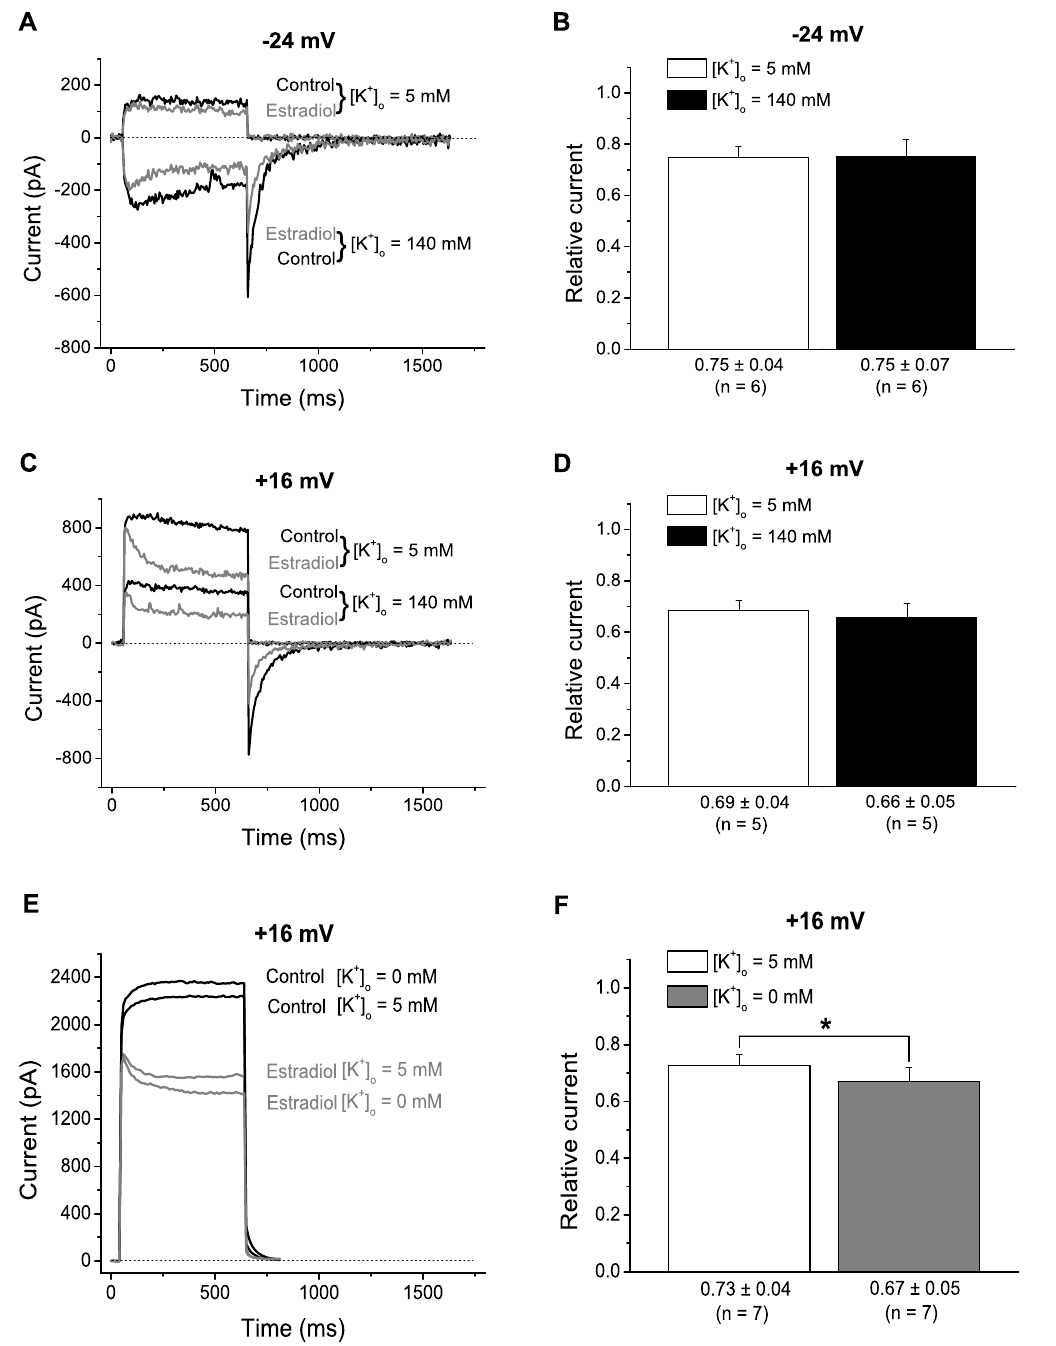
Figure 5. Effects of altered [K + ] o on block by 17- b -estradiol. A, currents recorded at 600-ms voltage steps to 2 24 mV from 2 74 mV. At 2 24 mV currents in standard [K + ] o of 5 mM are outward ( top traces, control black ) with some reduction caused by 10 m M 17- b -estradiol ( grey ). With a [K + ] o of 140 mM, currents ( lower traces, control black ) are inward and 10 m M 17- b -estradiol ( grey ) also reduces the current. B, relative current (mean 6 S.E.M. from 6 cells) in 10 m M 17- b -estradiol, measured 590–600 ms after a voltage step as in A. C, currents as in A but with voltage step to + 16 mV. D, relative current (mean 6 S.E.M. from 5 cells) in 10 m M 17- b -estradiol, measured 590–600 ms after a voltage step as in C. E, currents recorded as in C, but with comparison between standard [K + ] o of 5 mM and [K + ] o =0 mM. F, relative current (mean 6 S.E.M. from 7 cells) in 10 m M 17- b -estradiol, measured 590–600 ms after a voltage step as in E. Note the slight, but significant difference in blocking effect recorded from the same cells when [K + ] o =5 mM and when [K + ] o =0 mM.